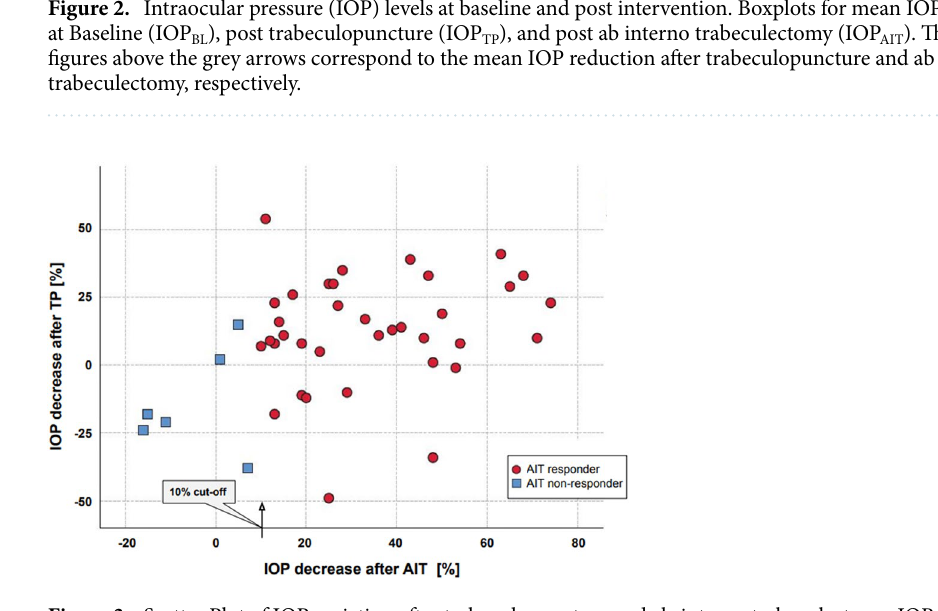
Figure 3. Scatter Plot of IOP variation after trabeculopuncture and ab-interno trabeculectomy. IOP alteration after trabeculopuncture (TP) and ab-interno trabeculectomy (AIT) are plotted. Negative percentages indicate an increase in IOP. AIT responders (red circles) and non-responders (blue boxes) can be distinguished. The cut-off for AIT success was set to 10%.